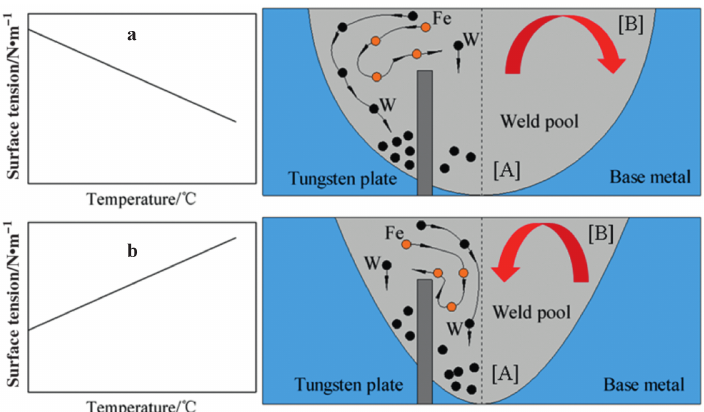
Figure 5: Marangoni convection mode in the